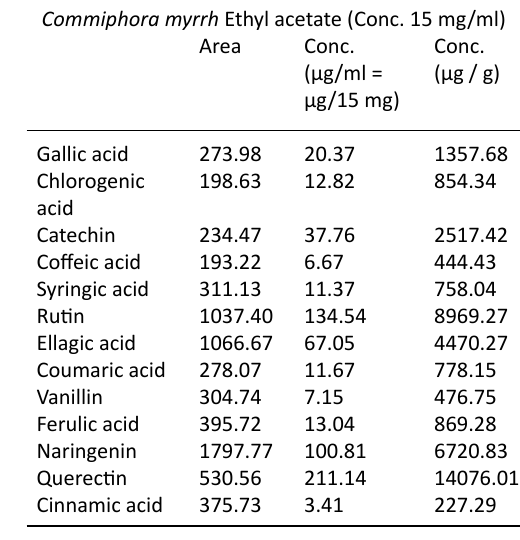
Table 4. Commiphora myrrh resin ethyl acetate extract